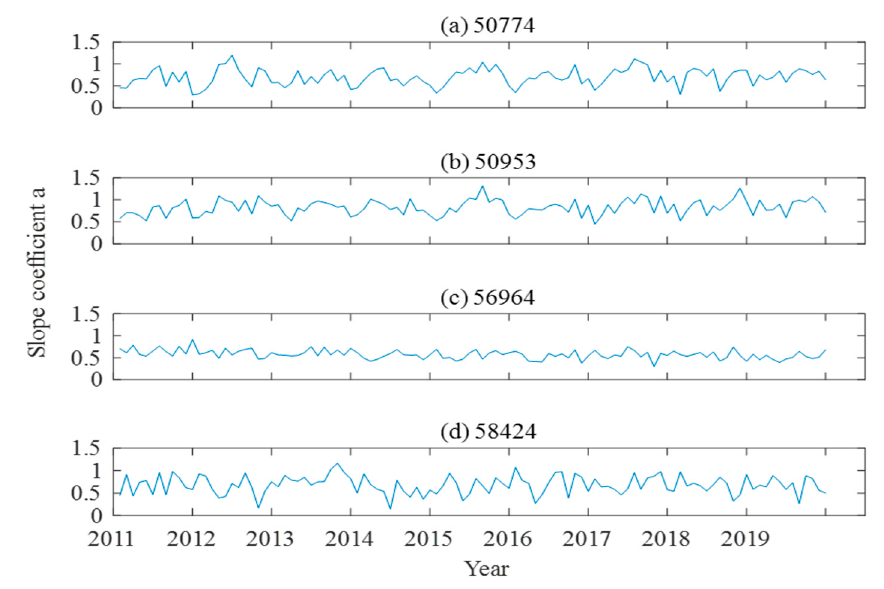
Figure 4. Monthly slope coefficient of the T m - T s model from 2011 to 2019. Table 1. Information about the 4 stations used in Figure